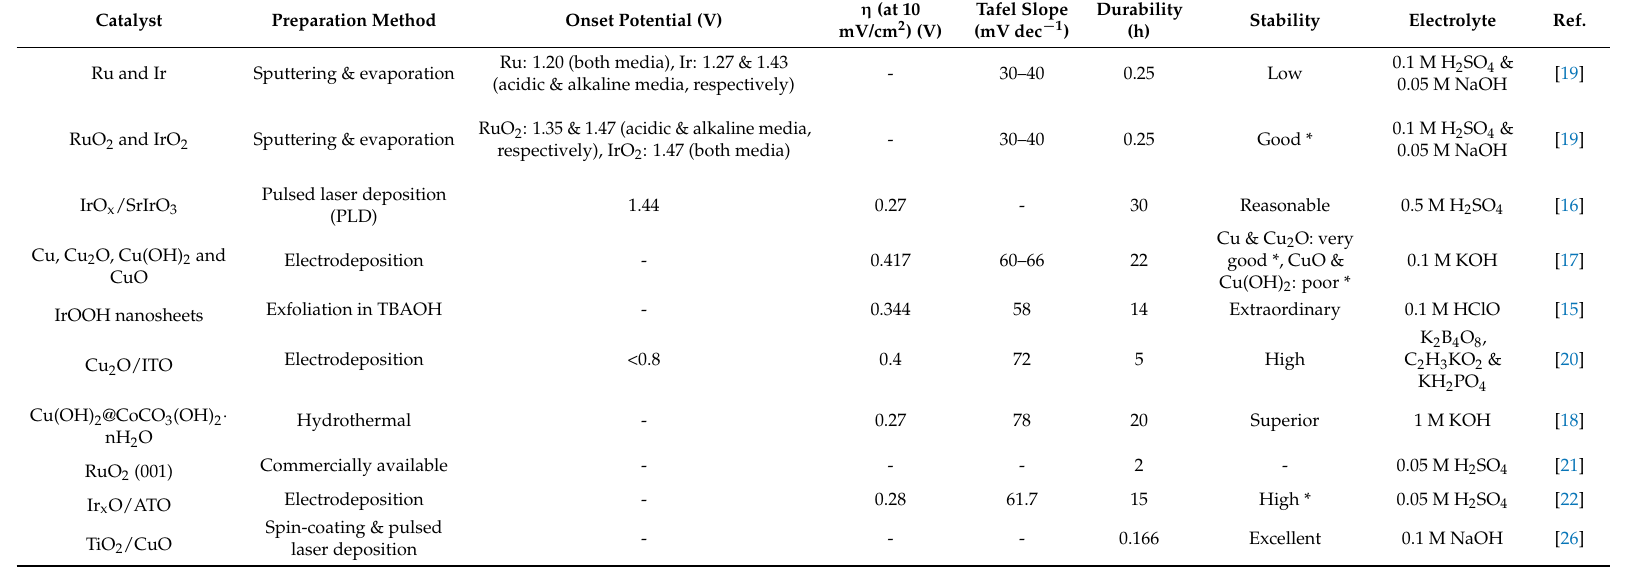
Table 1. Comparison of the electrocatalytic activity of recently reported Ru-, Ir-, and Cu-based catalysts (“durability” refers to maintenance of the catalytic performance at constant current conditions, while “stability” indicates the resistivity of a given catalyst towards dissolution/leaching of the active metal sites).